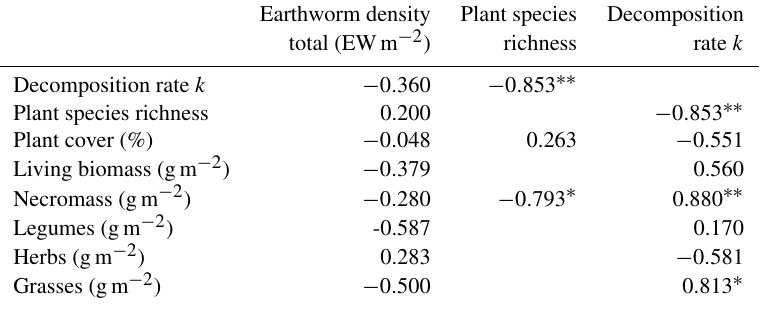
Table 3. Correlations between earthworm density, vegetation parameters and litter decomposition. Pearson and Spearman (only for plant cover) correlation coefficients. Missing results: no correlation was